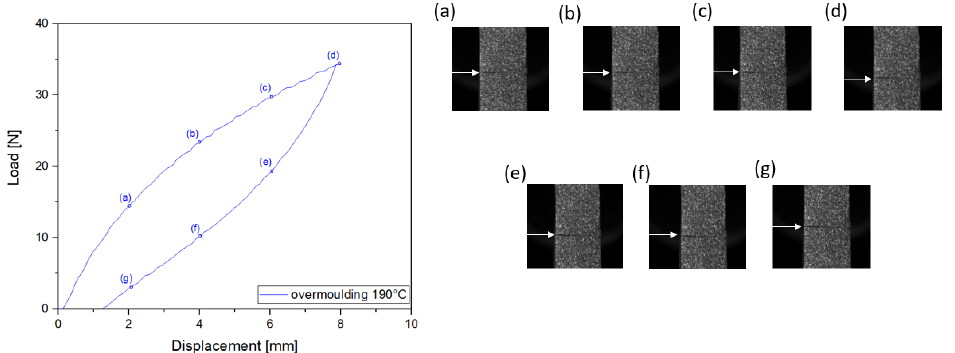
Figure 7. Cyclic loading 8 mm of specimens overmoulded at 190 ◦ C. Images ( a – g ) show a close-up view of the interface at different displacements during the test. TPV1 is at the bottom and TPV2 at the